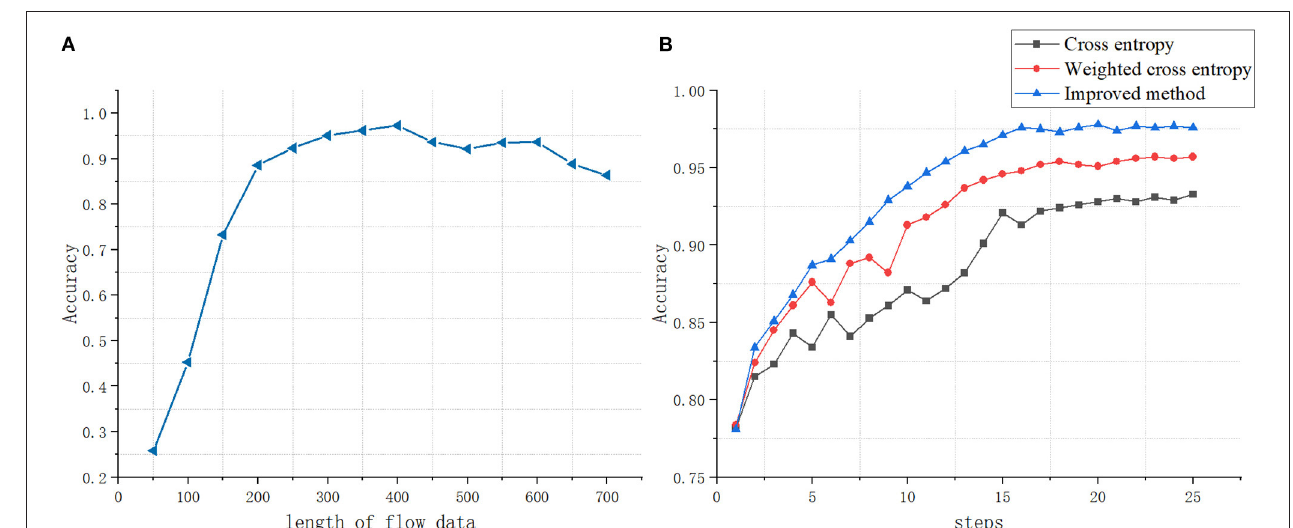
FIGURE 5 | (A) The impact of data stream length on classification accuracy. (B) The impact of different loss functions on classification accuracy.